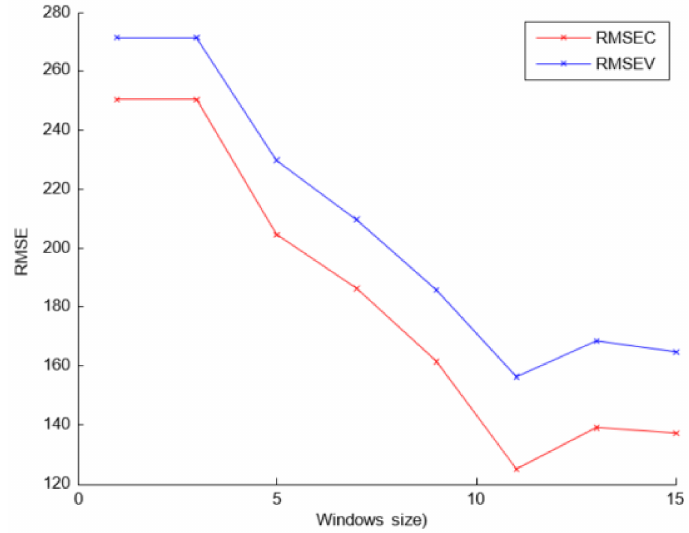
Figure 7. The RMSEC and RMSEV values when different set of samples were employed and different number of acquisitions per sample were